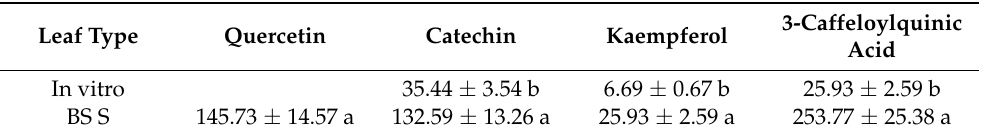
Table 4. HPLC-MS data of the identified and quantified compounds from leaves of A. chilensis ( µ g g − 1